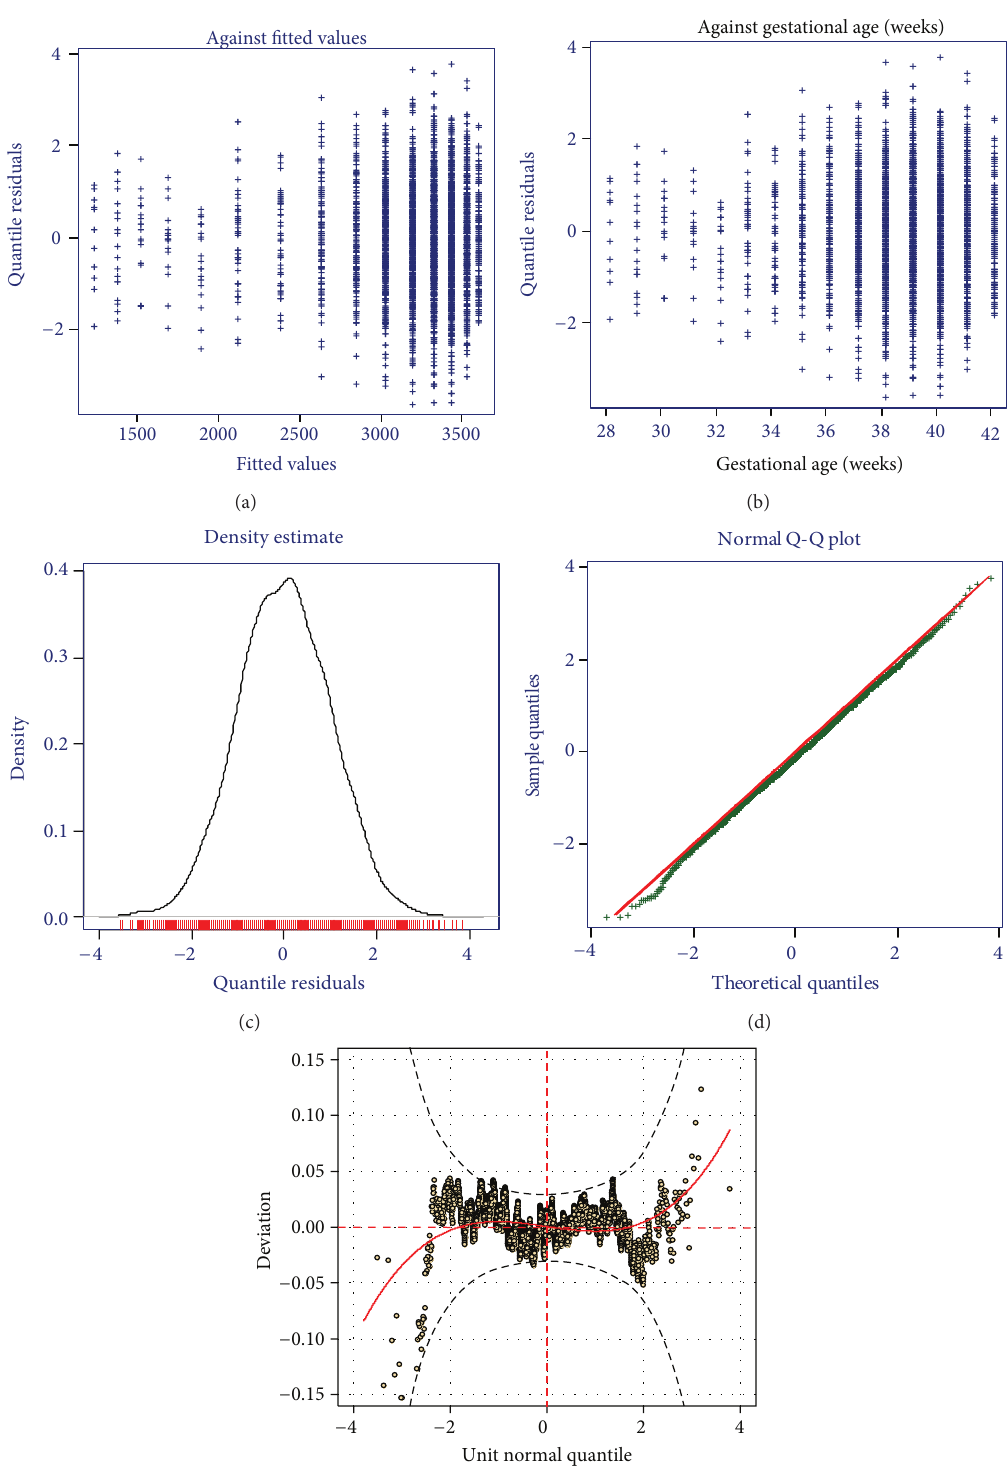
Figure 1: Residual and worm plots of birth weights of male Cameroonian